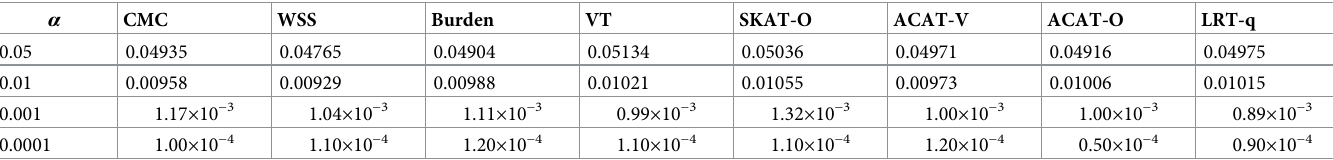
Table 1. False positive rate of eight rare variant test methods in